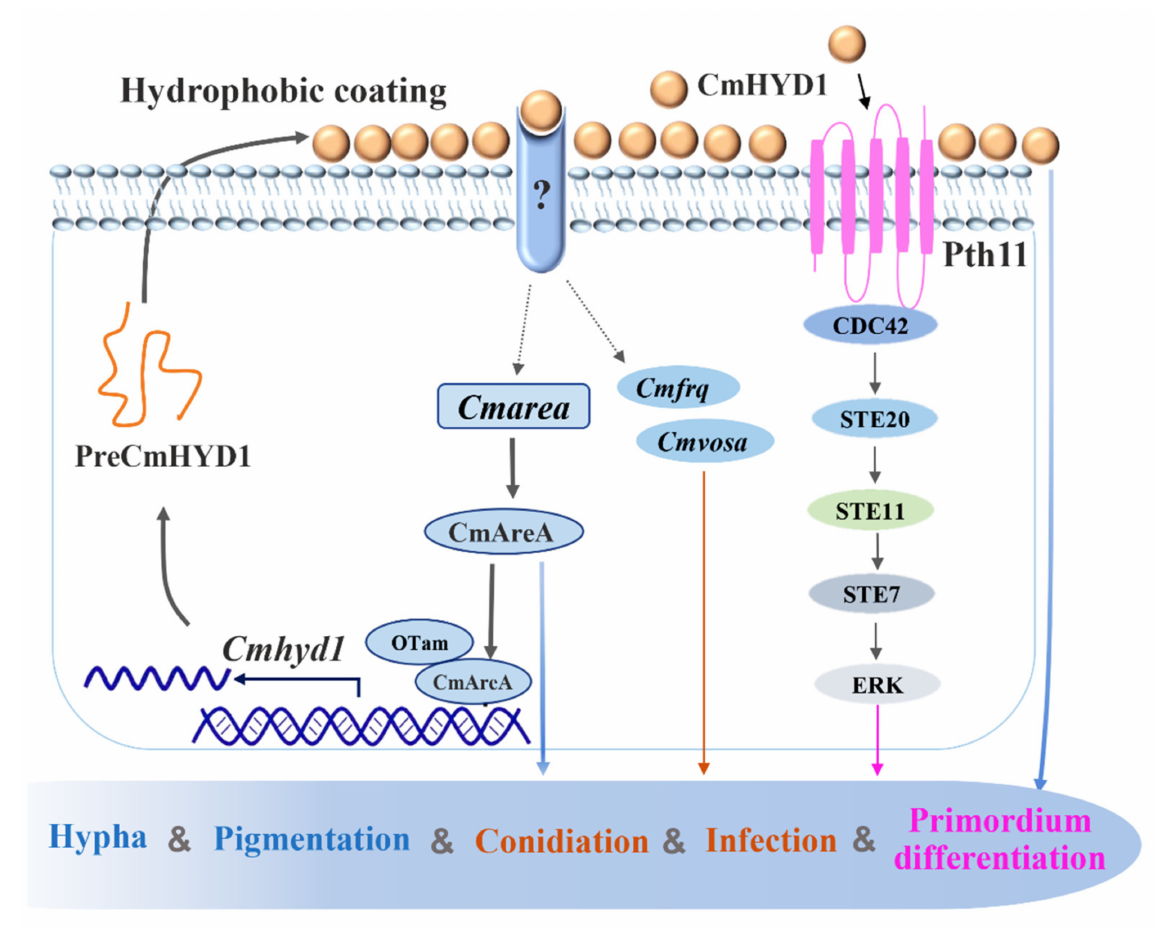
Figure 9. Putative model of Cmhyd1 regulating hypha growth, pigmentation, conidiation, hydrophobicity and infection as well as primordium differentiation in Cordyceps militaris . CmAreA directly activated the transcription of Cmhyd1 , cooperating with CmOTam. Cmhyd1 was expressed and CmHYD1 was secreted. CmHYD1 formed a hydrophobic coating for hyphae and conidia to ensure their hydrophobicity. CmHYD1 was involved in conidiation and infection as well as primordium differentiation by regulating the transcription of Cmfrq , Cmvosa and genes of the MAPK signaling pathway. CmHYD1 also regulated the transcript level of Cmarea via a positive feedback mechanism. Dotted arrows indicate the relationship was only confirmed at transcript levels. The “?” indicates unknown protein.